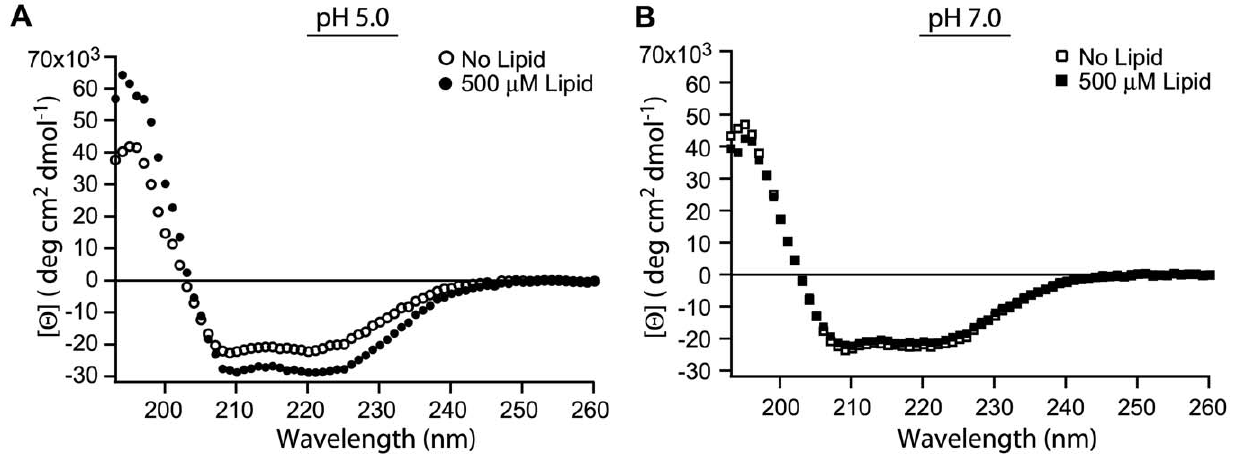
N ) or absence ( # ) of